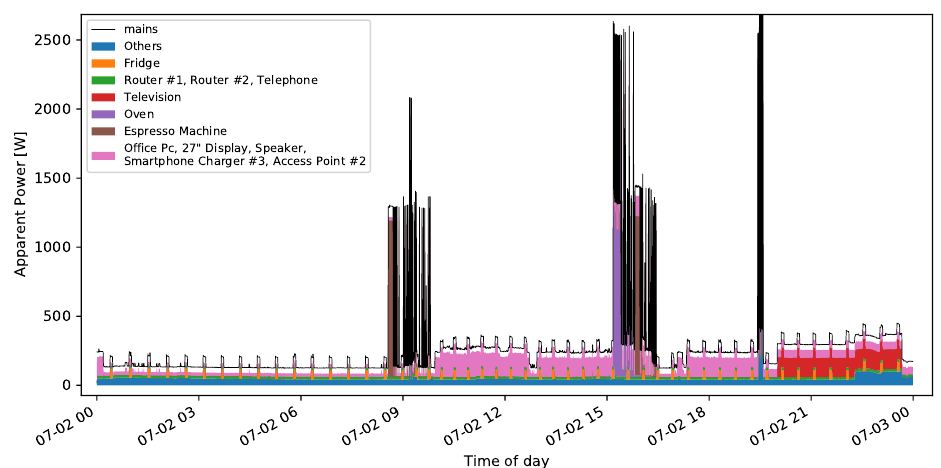
Figure 8. The power consumption of the apartment over one full day (2nd July 2020). The power is down-sampled to one sample every 3s. The black line indicates the power consumption recorded by the SmartMeter. The contribution of the six top-most consumers is shown as stacked colored blocks. The consumption of the remaining individually metered appliances are aggregated and shown as the blue block Others . A slight offset between the SmartMeter and the accumulated power of all PowerMeters can be seen.